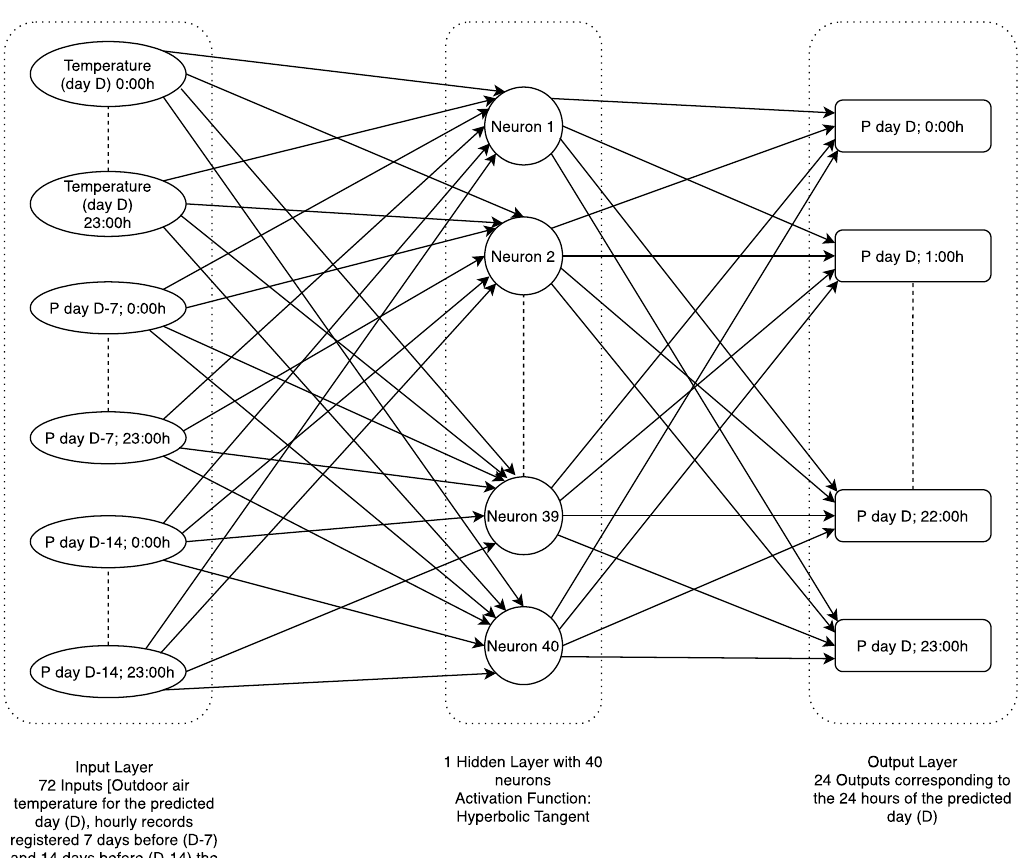
Figure 2. Representation of the multivariable artificial neural network